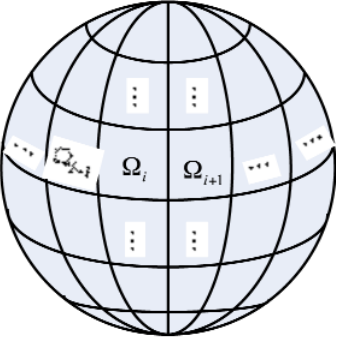
Figure 2. Sketch map of the local region X